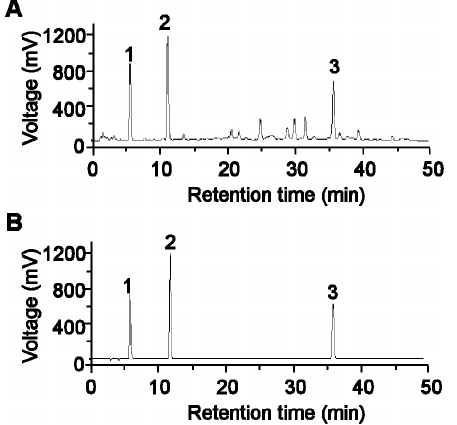
Figure 1. HPLC chromatographic profiles of major active components of Danshen injection. (A) Danshen injection. (B) Standards. Peaks represent: 1, 3,4-dihydroxyphenyl lactic acid; 2, protocatechuic aldehyde; 3, salvianolic acid